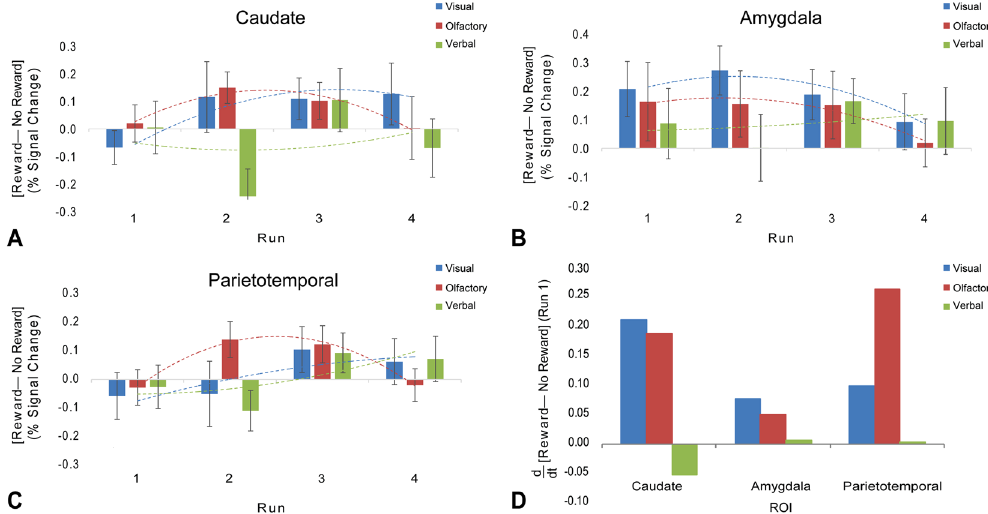
Figure 3. Percent signal change by ROI for the contrast of stimuli predicting Reward vs. No Reward. Unadjusted mean values across dogs by run and by modality ( blue = visual, red = olfactory, green = verbal). Error bars denote the standard error of the mean across dogs for each modality and run. Lines denote second- order polynomial trend lines across all runs for each modality and ROI. Consistent with studies of reward learning, there were main effects of [Reward-No Reward] across all ROIs ( p < 0.001), which was only marginally significantly different by modality ( p = 0.045). There was a significant interaction between [Reward—No Reward] and ROI ( p = 0.014), suggesting the magnitude of the effect was different in each region. All ROIs showed evidence of varying time course ( p = 0.018), which differed by modality ( p = 0.006), consistent with different rates of learning and habituation by modality. ( A ) Averaged beta values in the caudate show marked learning curves for visual and olfactory stimuli. ( B ) Averaged beta values in the amygdala show learning curves across all stimulus modalities, but verbal stimuli peak later than visual and verbal stimuli. ( C ) Averaged beta values in the parietotemporal area show weak learning effects for all modalities. ( D ) Comparison of initial learning rates for each modality for Run 1. Bars denote the temporal derivative (d/dt) of the polynomial fit for [Reward—No Reward] by modality and ROI. Across all three ROIs, percent signal change to visual and olfactory stimuli occur at a faster rate than verbal stimuli, and is evident in the first few